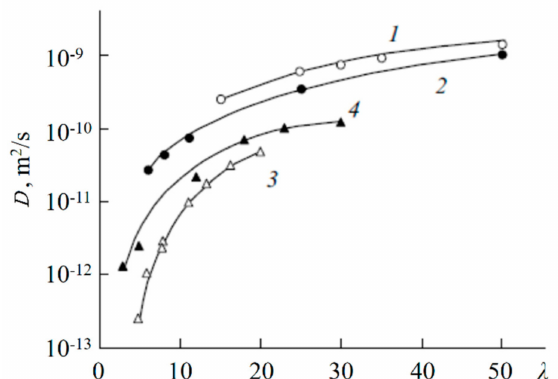
Figure 49. Diffusion coefficients of lithium cations in the system lithium salt-disulfophthalic acid- water ((1) is terephthalic, (2) is isophthalic) as a function of the moisture content in macroporous sulfonate cation-exchange CU-23 (4) and perfluorinated sulfonate cation-exchange membrane MF- 4SC (3) [59]. Exchange capacity/mg-equiv · g − 1 : 0.86 for MF-4SC, 5 for macroporous cation exchanger CU-23, 2 for aromatic disulfo-containing polyamides. Reprinted with permission from [59]. Copy- right 2010 Springer Nature.